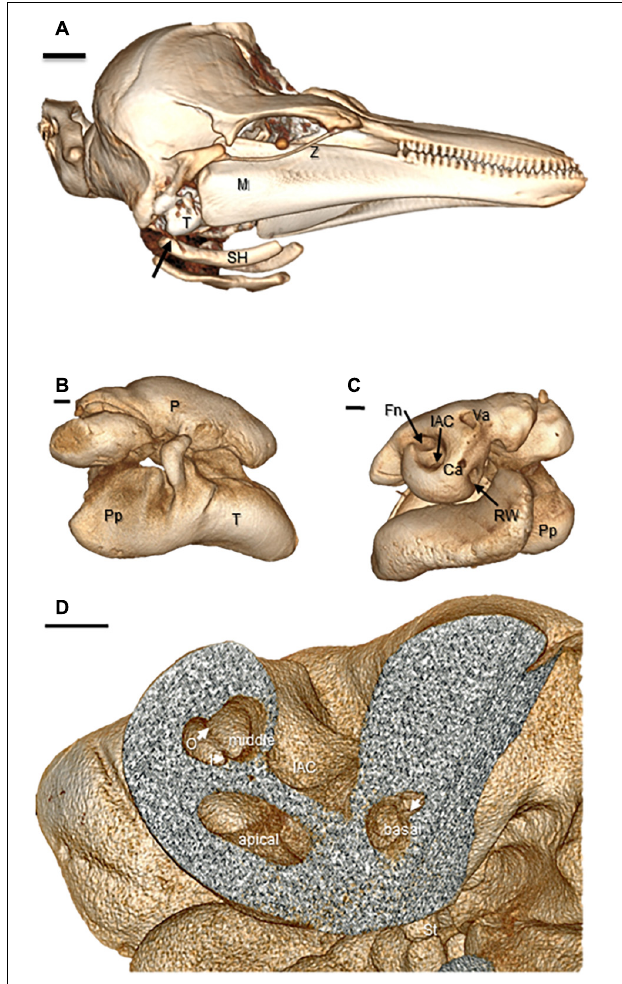
FIGURE 2 | Three-dimensional reconstructions of CT images of the entire head and auditory bullae of an adult male Phocoena phocoena (harbor porpoise ). Ca, cochlear aqueduct; Fn, facial (VIIth) nerve canal; IAC, internal auditory canal of the acousto-vestibular (VIIIth) nerve; I, inner osseous lamina; M, mandible; O, outer osseous laminae; Pp, tympanic posterior prominence; P, periotic bulla; RW, round window; SH, stylohyal bone; St, stapes head; T, tympanic bulla; Va, vestibular aqueduct; Z, zygomatic (Images copyright© 2020 DK, all rights reserved). (A) Whole head image reconstructed from helical CT scan data with 1 mm slice acquisitions. Right lateral view of head shows the tympano-periotic complex in the peribullar fossa posterior to the mandible and associated stylohyal structures. Scale bar = 2.0 cm. (B) Lateral view of right tympano-periotic bullae images obtained from microCT with 500–1,500 projections and 33 micron voxel resolution. Scale bar = 2.0 mm. (C) Medial views of right ear tympano-periotic complex. Scale bar = 2.0 mm. (D) Cut-away of the periotic showing cochlear canal cross sections of the basal, middle, and apical turns with differences in spiral laminae separations (arrows) that reflect basilar membrane widths at each level. Scale bar = 2.0